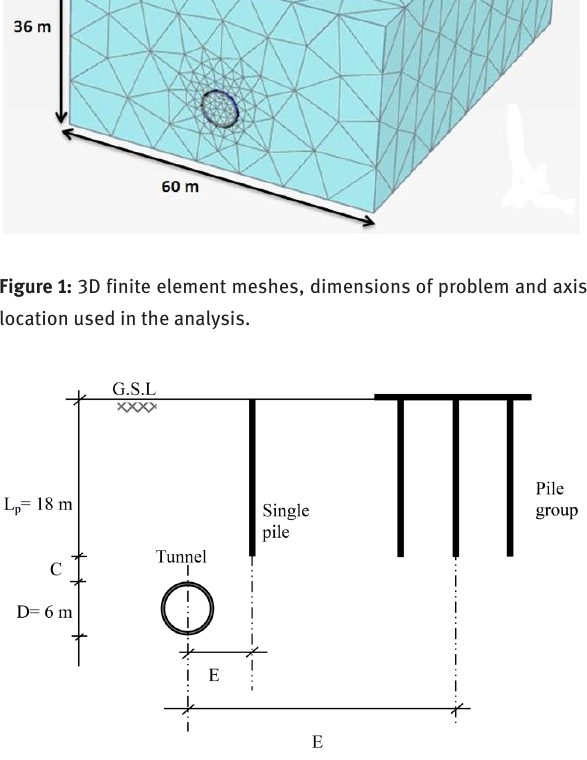
Figure 2: Underground location of tunnel relative to a single and group of piles. Fig. 2 Underground location of tunnel relative to a single and group of piles